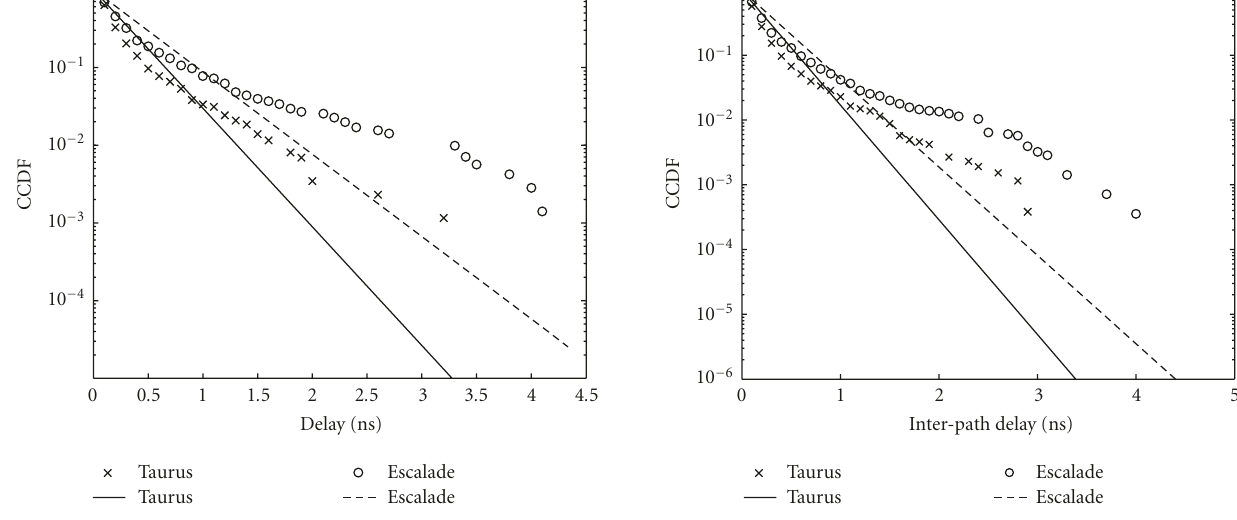
Figure 11: CCDF of interpath arrival intervals and the best-fit exponential distributions for measurements beneath the chassis.